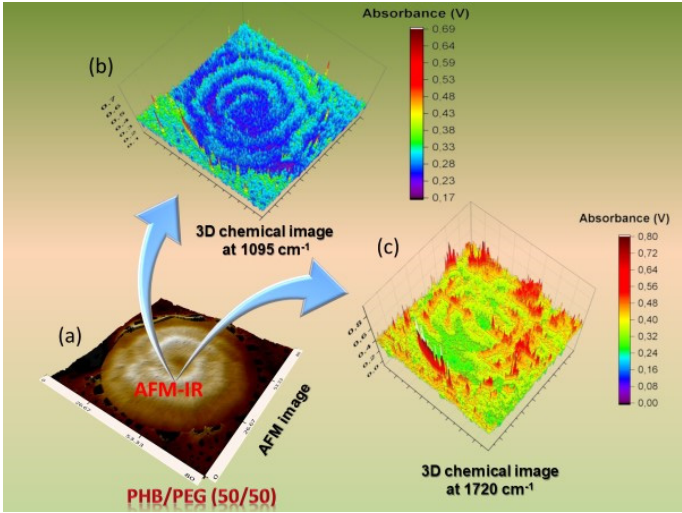
Figure 9. The PHB / PEG (50 / 50) blend isothermally crystallized at 40 ◦ C: ( a ) tridimensional chemical Figure 9. The PHB/PEG (50/50) blend isothermally crystallized at 40 °C: a ) tridimensional chemical image at the 1720 cm − 1 band; ( b ) 3D AFM image and ( c ) 3D chemical image at the 1095 cm − 1 band. image at the 1720 cm − 1 band; b ) 3D AFM image and c ) 3D chemical image at the 1095 cm − 1 band. Reproduced with copyright permission from American Chemical Society , Nguyen-Tri et al. Reproduced with copyright permission from American Chemical Society, Nguyen-Tri et al. [161].